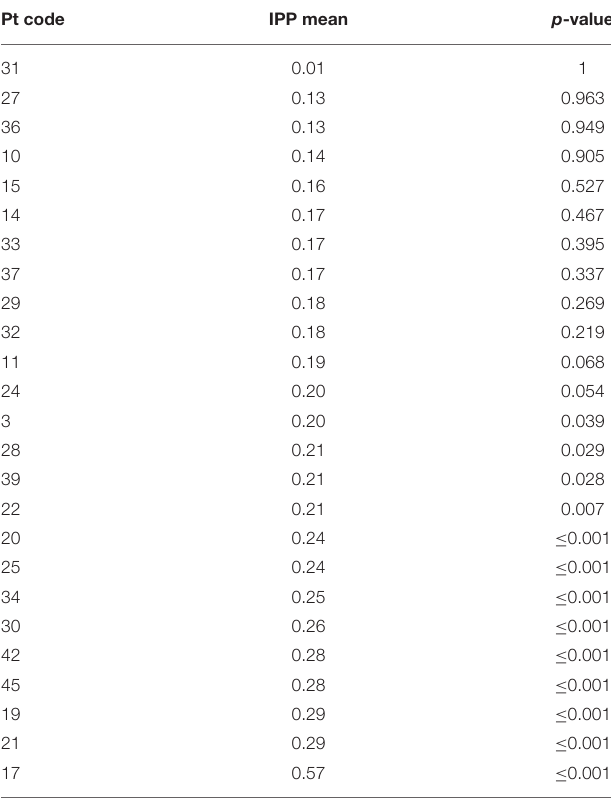
TABLE 4 | Test statistics for Intrusion Perseveration Probability (IPP)